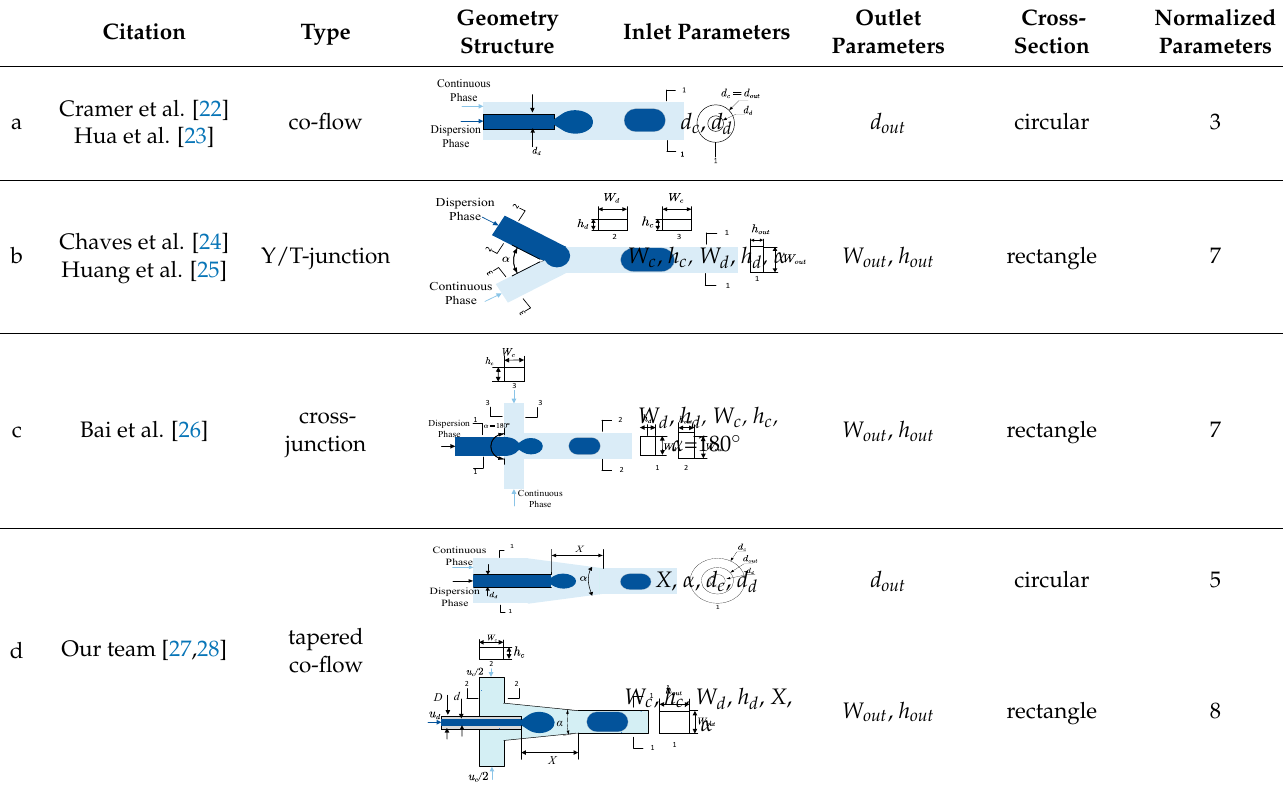
Table 1. Normalized model for different geometry configurations in the